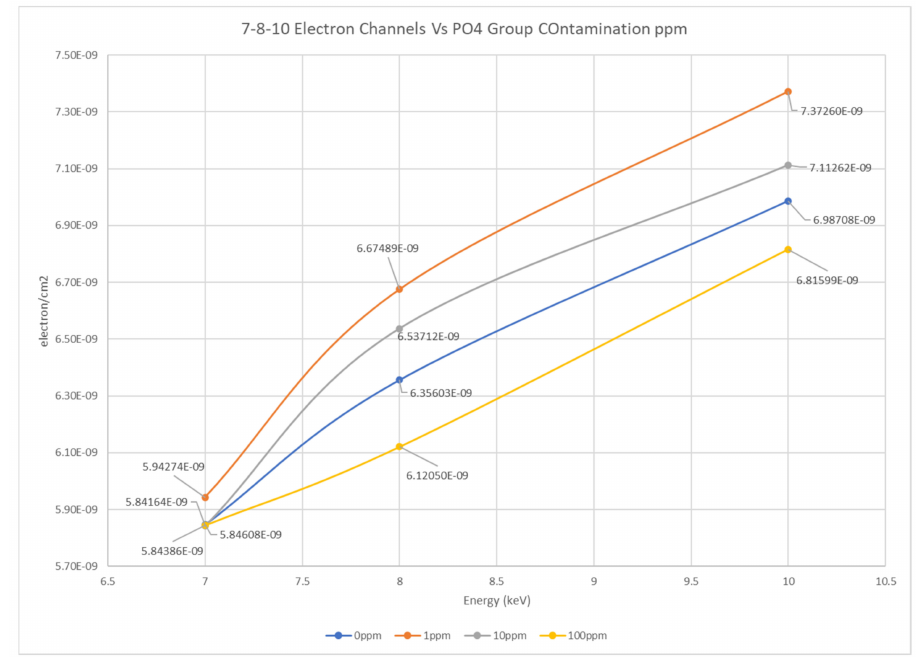
Figure 17. Low band electron spectrum—air sample vs.